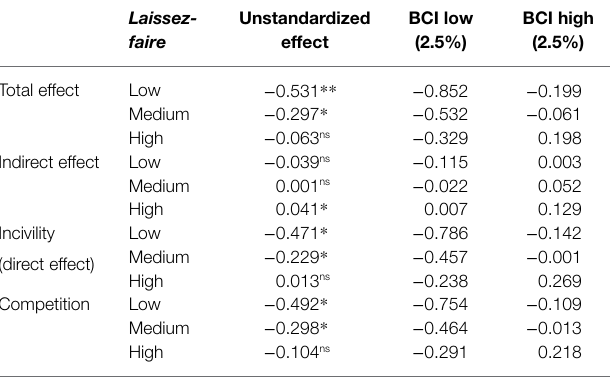
TABLE 3 | Simple slopes tests after 5,000 bootstraps. Laissez-